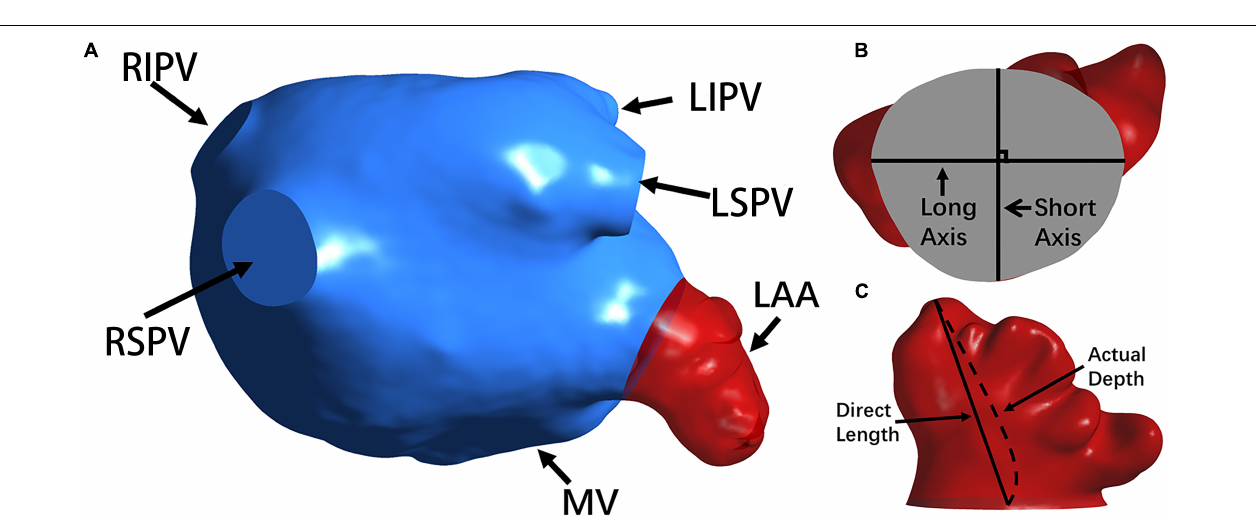
FIGURE 2 | The morphology of the LA and LAA. (A) The LA structure. The LAA, MV and PVs (i.e., RSPV, RIPV, LSPV, and LIPV) are shown. (B) The long axis and short axis of the LAA orifice. (C) The direct length and actual depth of the